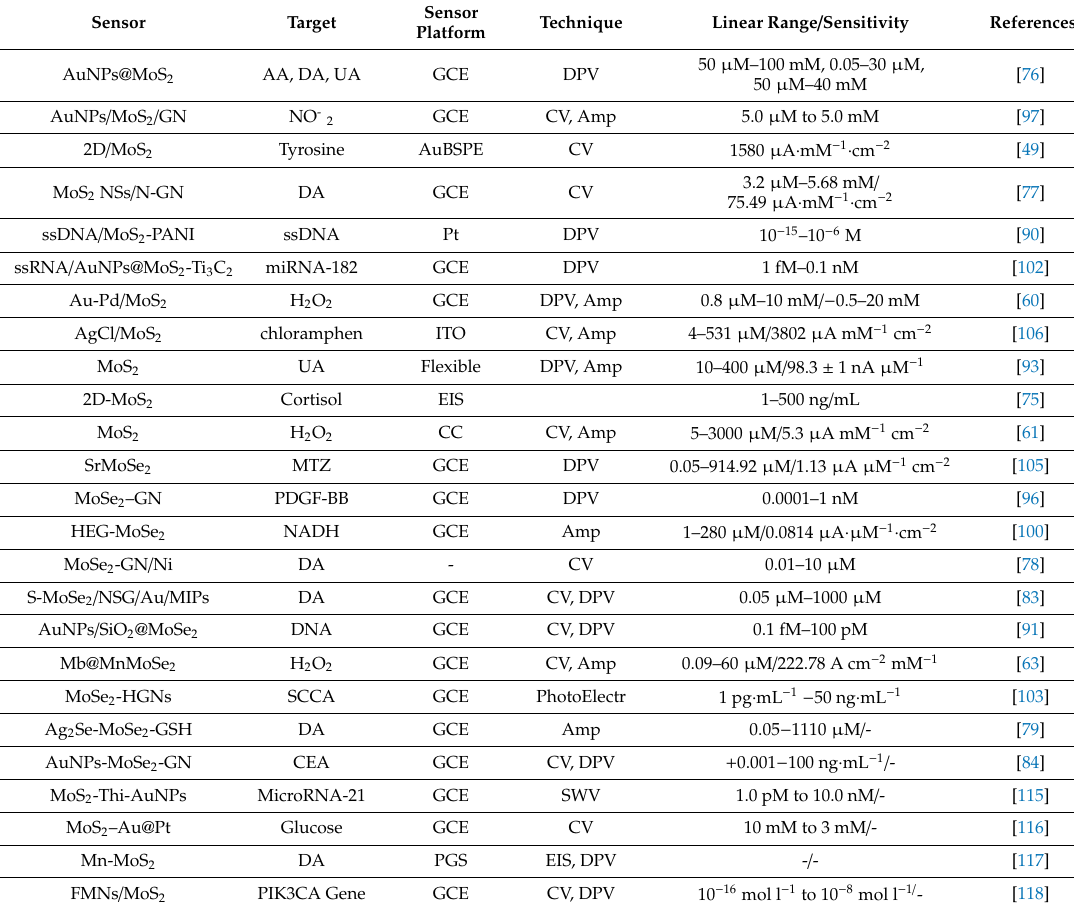
Table 1. 2D Mo-dichalcogenides sensors.